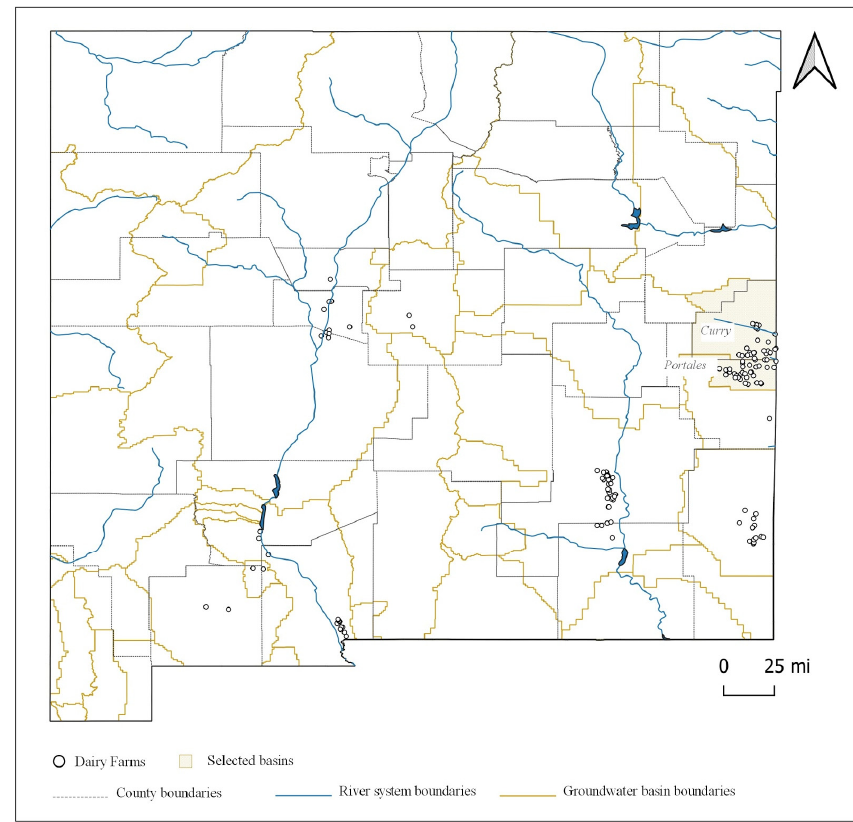
Figure 4. Groundwater basins in New Mexico.